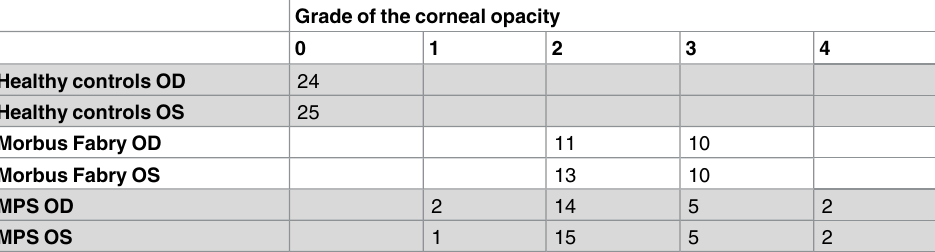
Table 1. Grade of corneal clouding in the right (OD) and left (OS) eyesin all study groups. Grade of the corneal opacity